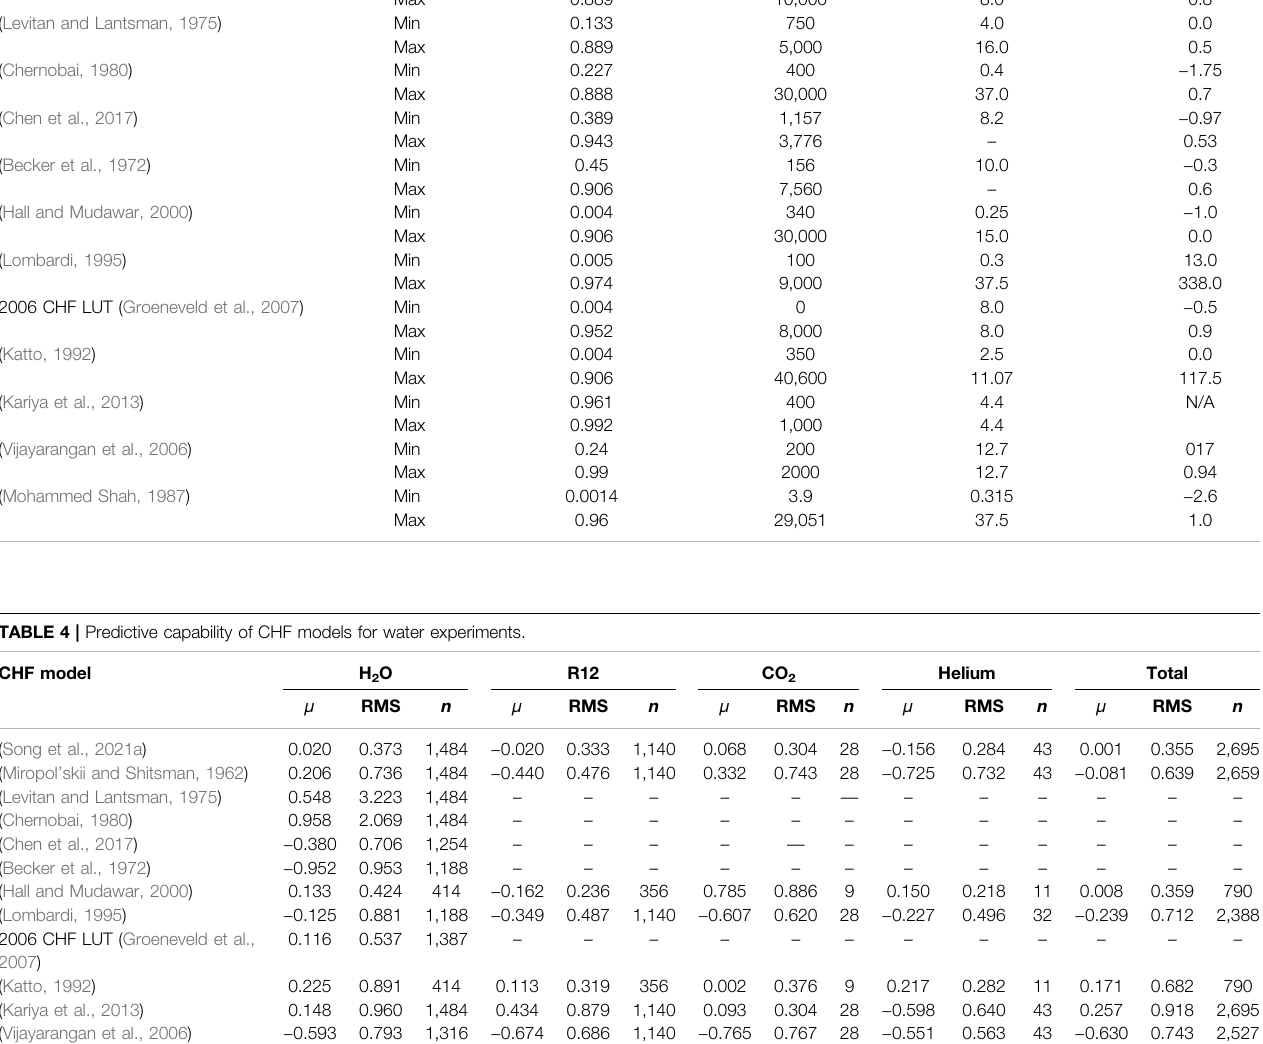
Figure 7A is the comparison of CHF for pressure at 16.0 and 20.0 MPa, with mass fl ux at 1,000 kg/(m 2 · s) and tube diameter at 10 mm. Figure 7B shows the results with constant mass fl ux at 1,500 kg/(m 2 · s) and tube diameter at 10 mm, while the pressures